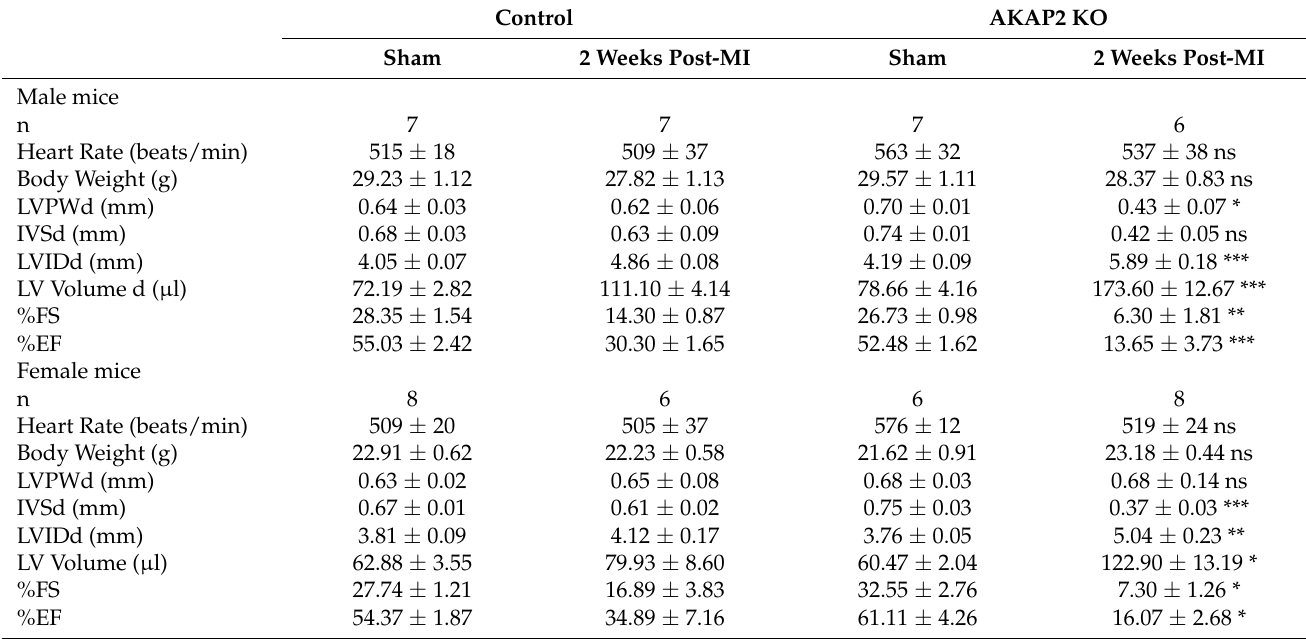
Table 2. Physiological and echocardiographic parameters in control and AKAP2 KO mice two weeks post MI or sham